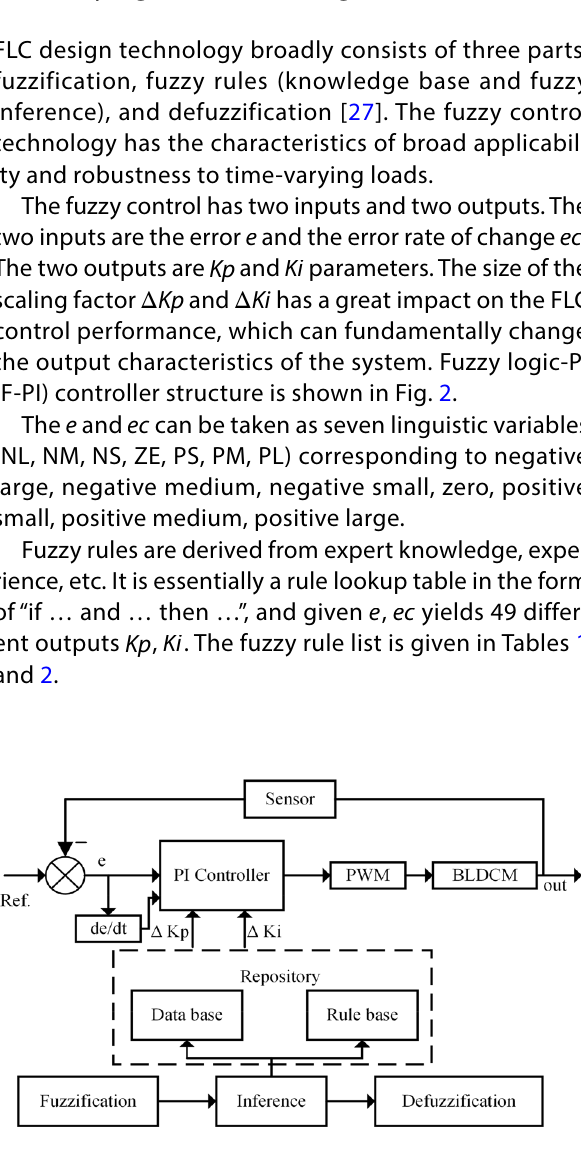
Fig. 1 Structure of conventional PI controller Fig. 2 Structure of F-PI